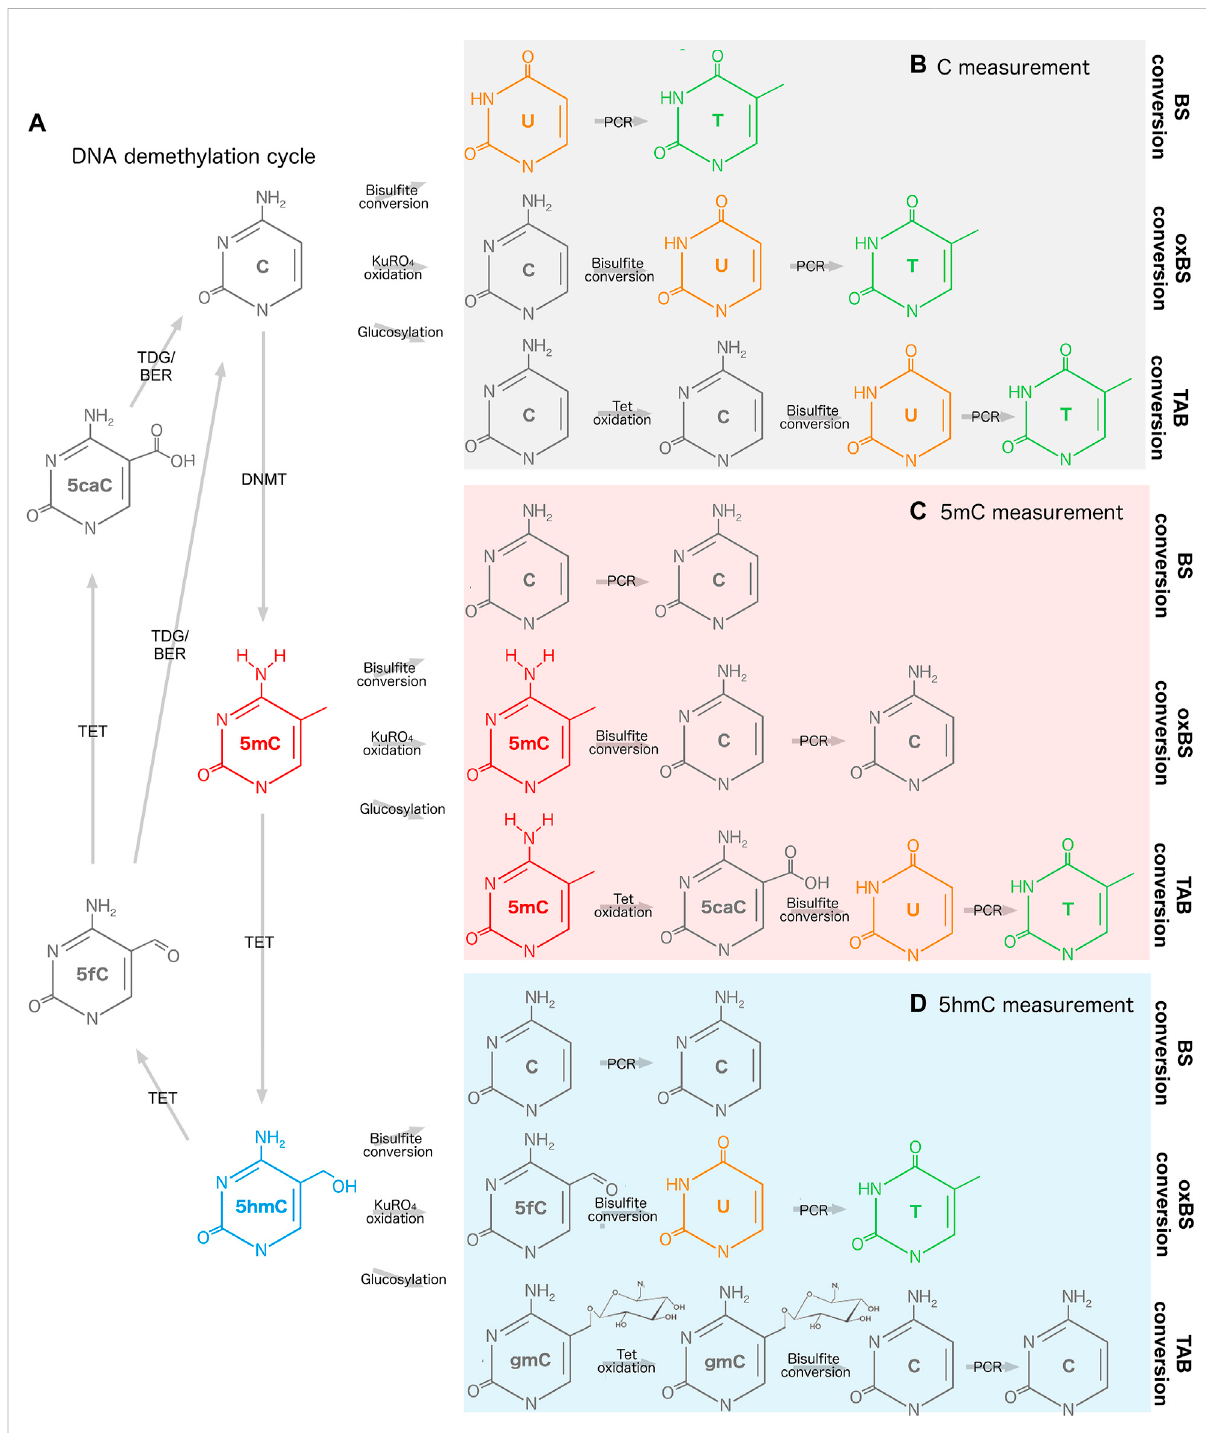
FIGURE 1 Measurement of DNA methylation and hydroxymethylation. (A) DNA demethylation cycle and reaction intermediates. (B) Bisul fi te, oxidative bisul fi te,and TET-assisted bisul fi teconversionofcytosine. (C) Bisul fi te,oxidative bisul fi te,and TET-assisted bisul fi teconversion of5mC. (D) Bisul fi te, oxidative bisul fi te, and TET-assisted bisul fi te conversion of 5hmC. 5caC, 5-carboxylcytosine; 5fC, 5- fl uorocytosine; 5hmC, 5- hydroxymethylcytosine; 5mC, 5-methylcytosine; BER, base excision repair; BS, bisul fi te; C, cytosine; DNMT, DNA methyltransferase; gmC, β - glucosyl-5-hydroxymethylcytosine; oxBS, oxidativebisul fi te;PCR, polymerase chain reaction; T, thymine; TAB, TET-assisted bisul fi te;TDG, thymine DNA glycosylase; TET, Ten-Eleven Translocation; U,